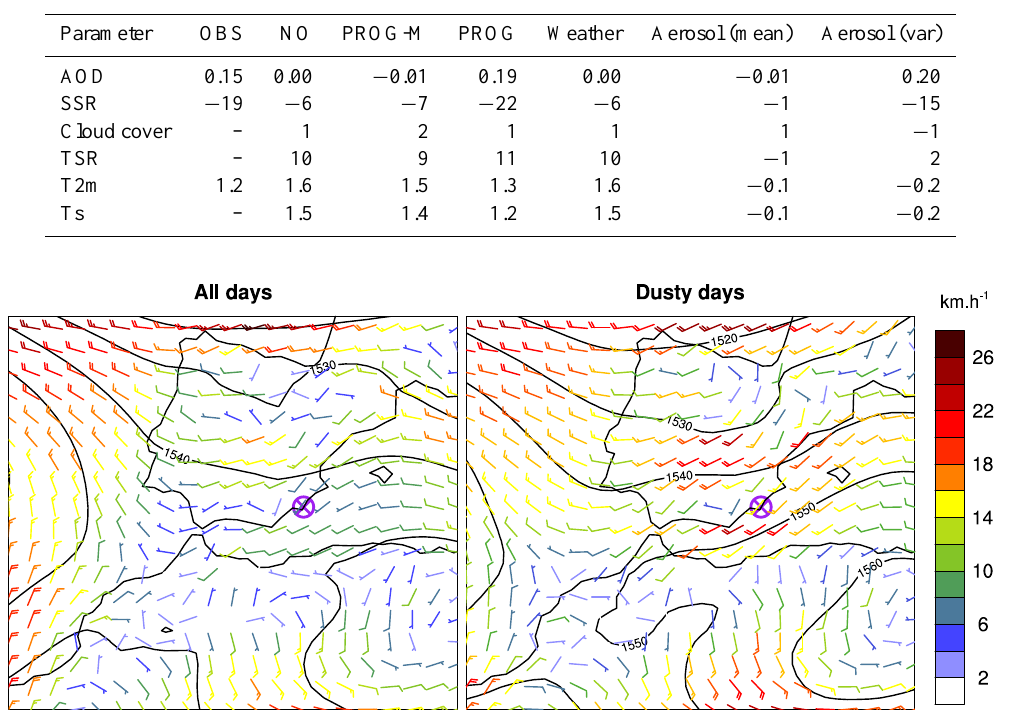
Fig. 12. Average AOD (a), downward SSR (b), cloud cover (c), downward TSR (d), 2m-temperature (e) and soil temperature (f) difference between the dusty and the set of all the days in fourteen stations (presented in Table 1) in summer 2012 for the NO, PROG-M and PROG simulations, as well as observations (AERUS-GEO for AOD, ground-based measurements for the other parameters). For Lampedusa and the buoys in the Gulf of Lions and Azur, 2m-temperature has been replaced by SST.